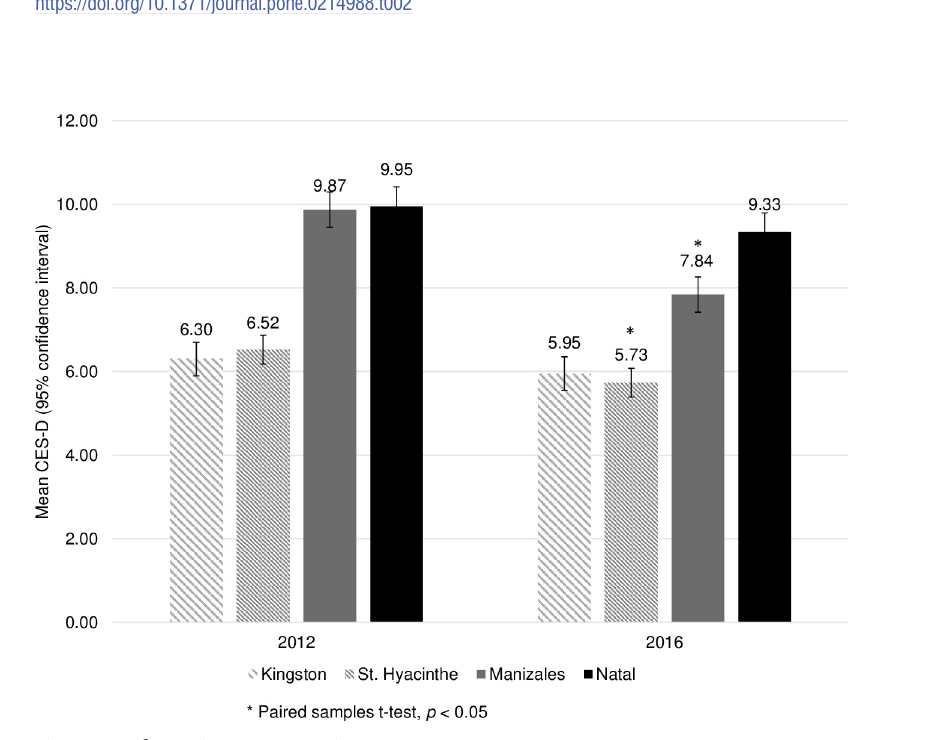
Fig 2. Mean depression scores over